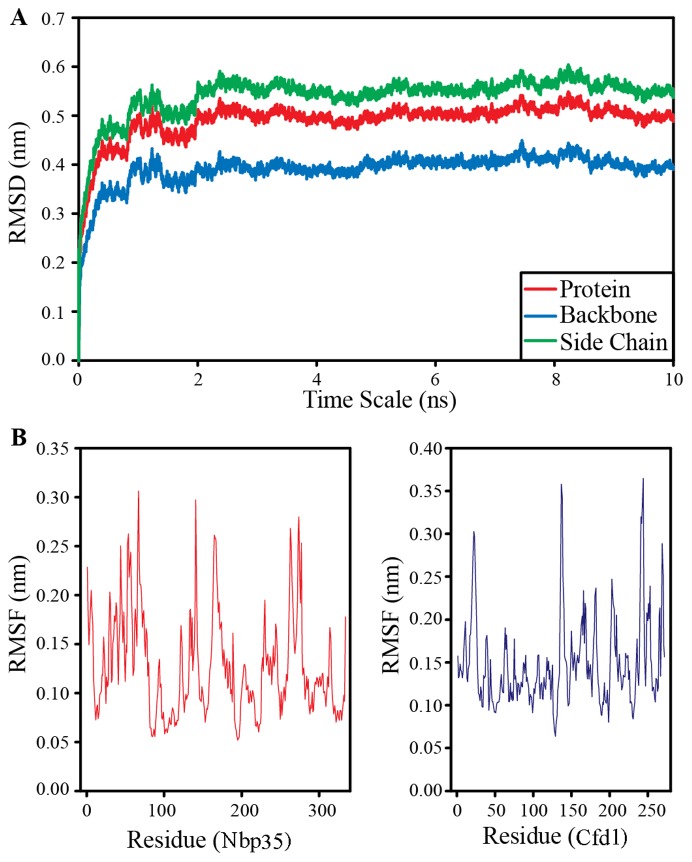
RMSD and RMSF profile of Nbp35-Cfd1 complex.(A) RMSD profile of Nbp35-Cfd1 complex for all-atoms (red), backbone atoms (blue) and side chain (green) plotted as a function of time (B) Root mean square fluctuation for Nbp35 and Cfd1 plotted against time from MD simulation.